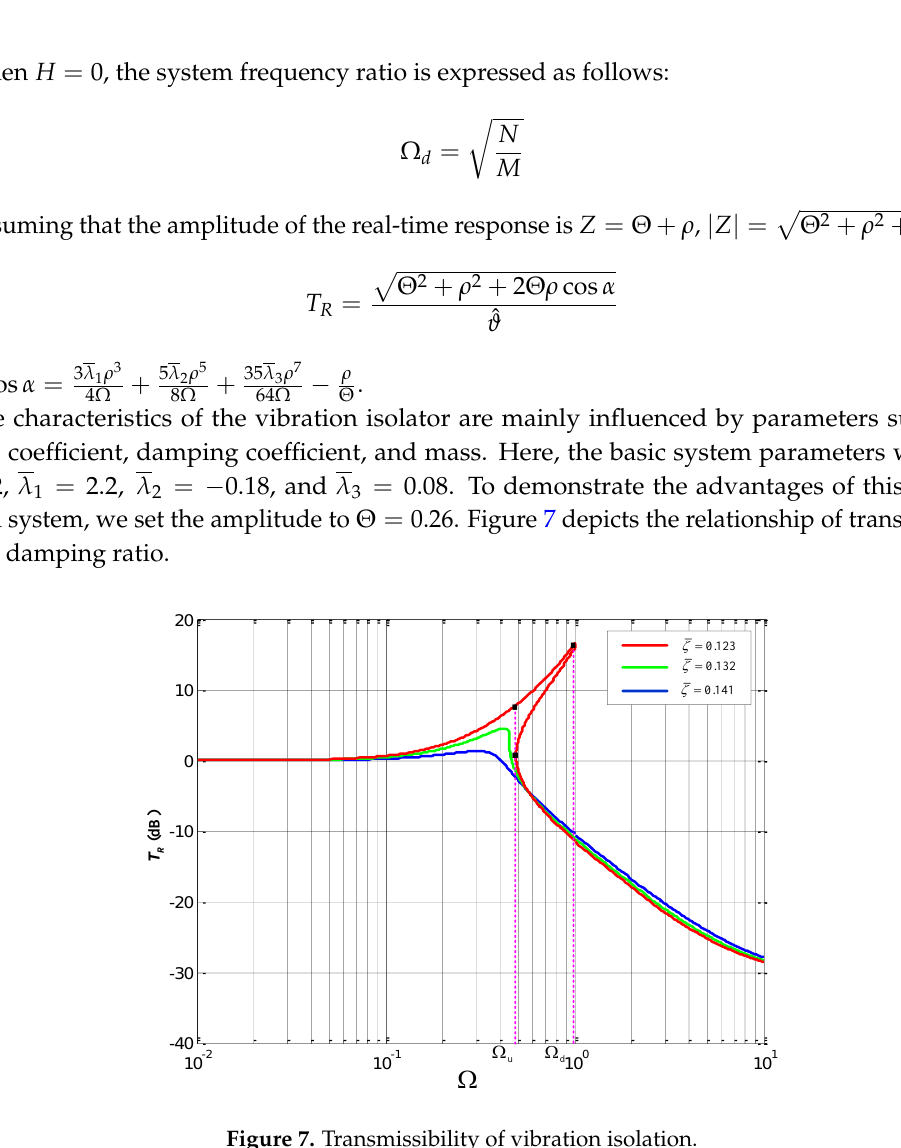
Figure 7. Transmissibility of vibration isolation.